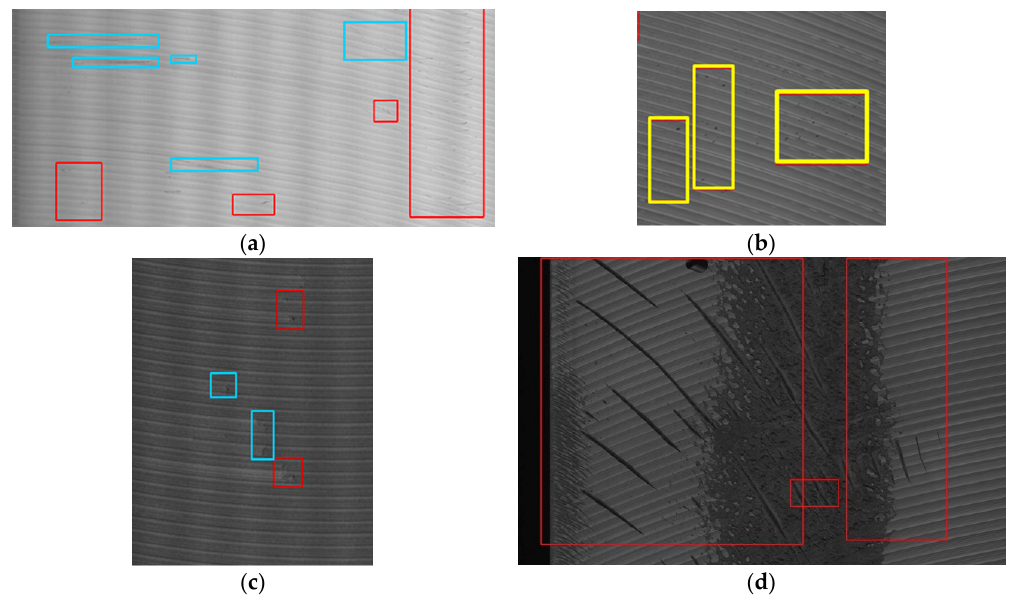
Figure 20. Failure cases of our method: ( a ) False negatives (blue box) of Sc (to facilitate observation, we increased the contrast by 20%); ( b ) False positives (yellow box) of PSI; ( c ) False negatives (blue box) of PSI (to facilitate observation, we increased the contrast by 20%); ( d ) Incomplete detection of OF.